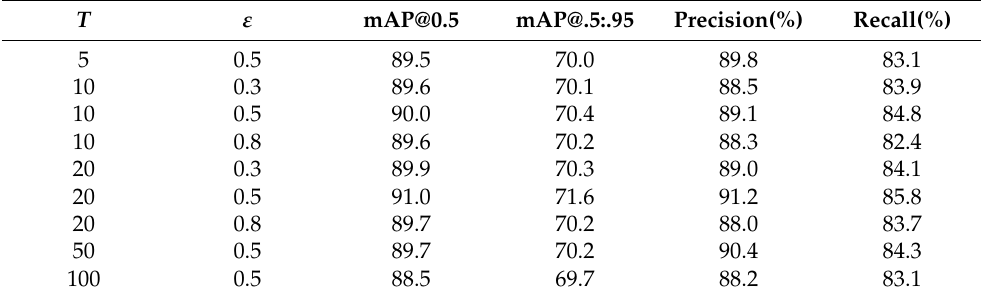
Table 8. Comparison of detection performance for different combinations of values.